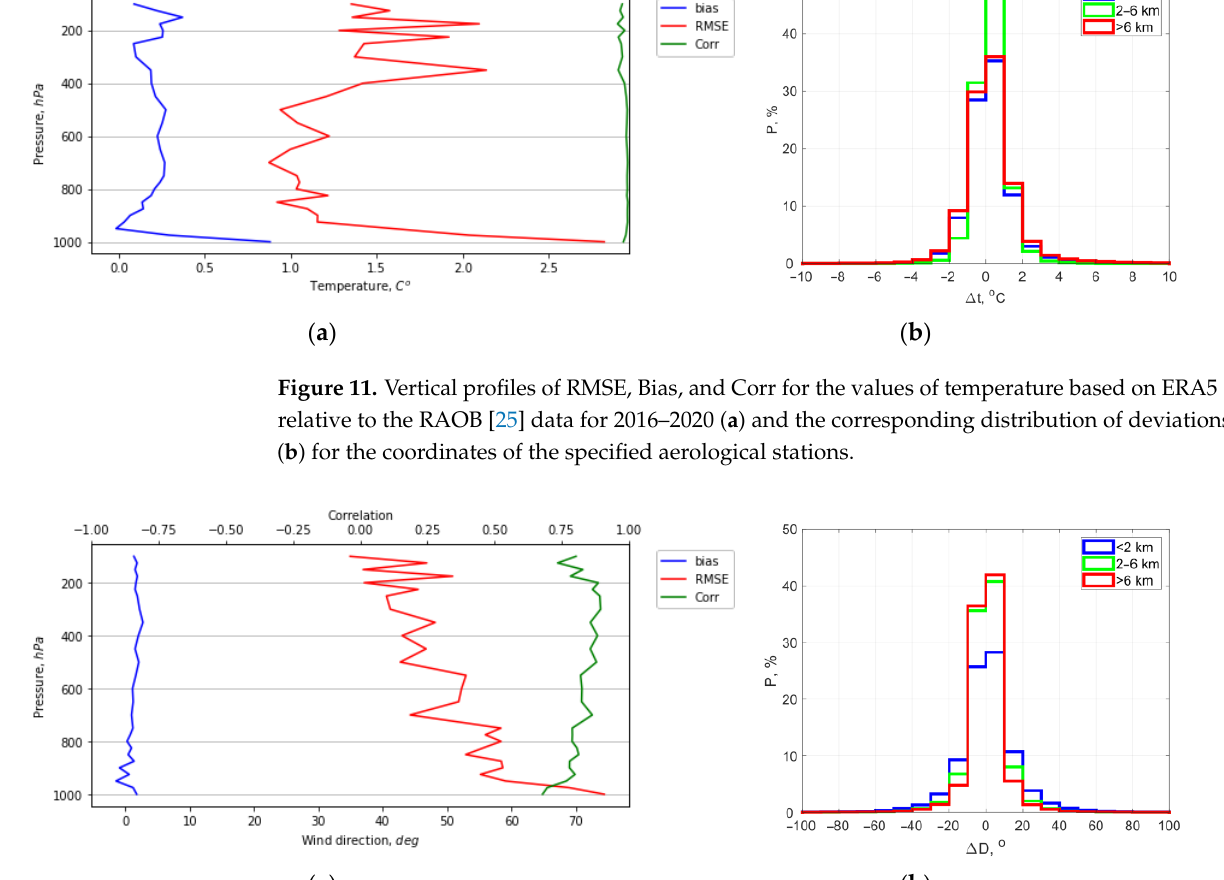
Figure 12. Vertical profiles of RMSE, Bias, and Corr for the values of wind direction based on ERA5 [39] relative to the RAOB [25] data for 2016–2020 ( a ) and the corresponding distribution of deviations Δ D ( b ) for the coordinates of the specified aerological stations.